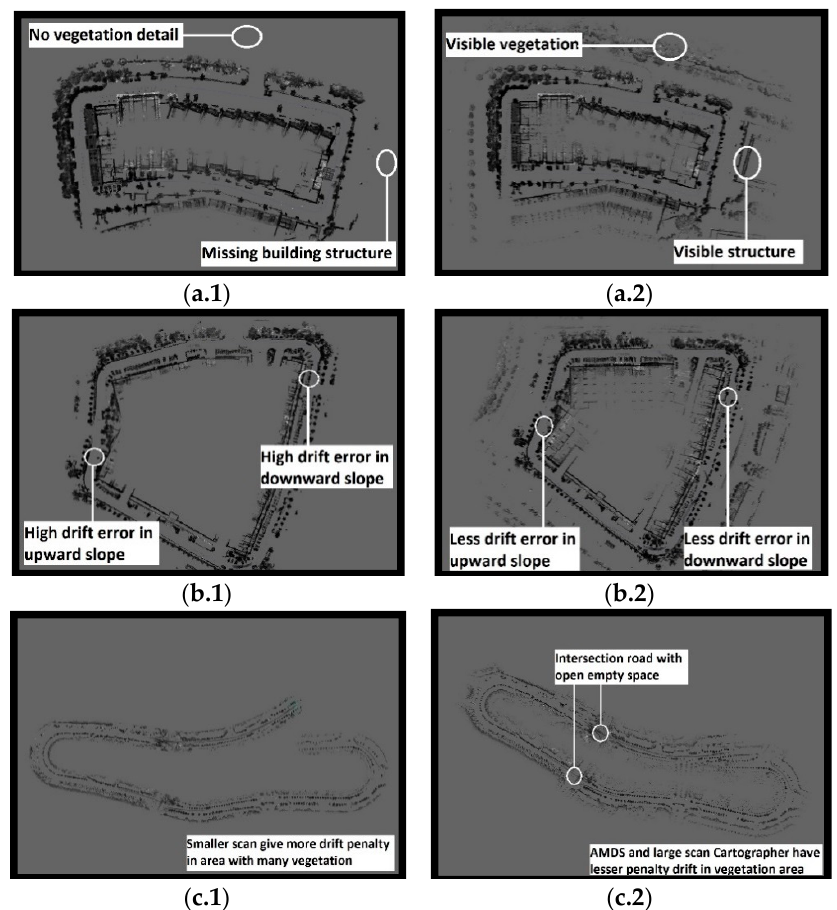
Figure 11. Map accuracy and detail: ( a ) Result map 1, ( b ) result map 4, ( c ) result map 6, ( 1 ) Cartographer using 25 m scan distances, and ( 2 ) Cartographer using adaptive multistage distance scheduler (AMDS) (60 m/25 m) scan distances.